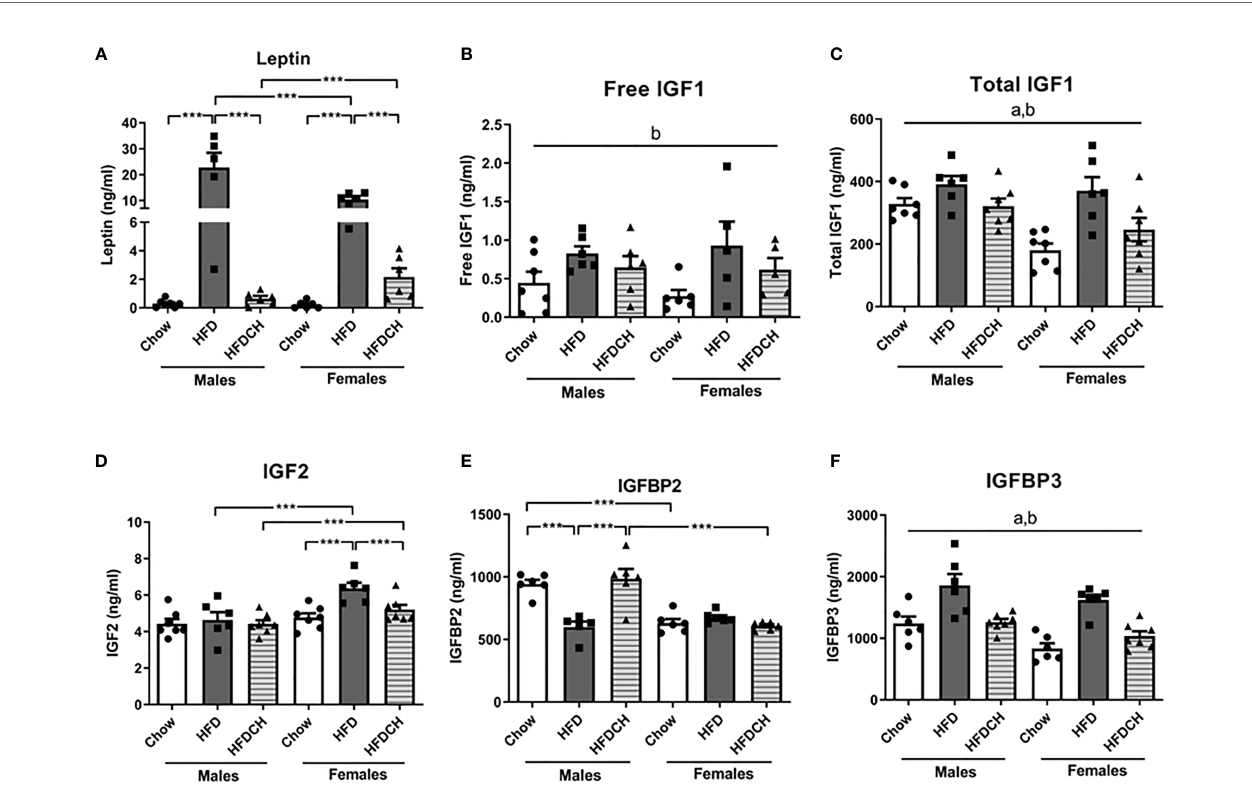
FIGURE 4 | Circulating levels of leptin (A) , free insulin-like growth factor (IGF)1 (B) , total IGF1 (C) , IGF2 (D) , IGF binding protein (IGFBP)2 (E) and IGFBP3 (F) in mice that received chow or a high-fat diet (HFD) for 12 weeks, or 8 weeks of HFD and then chow during the last 4 weeks (HFDCH) of the study. ***p < 0.001, a, effect of the sex; b, effect of the diet. n =